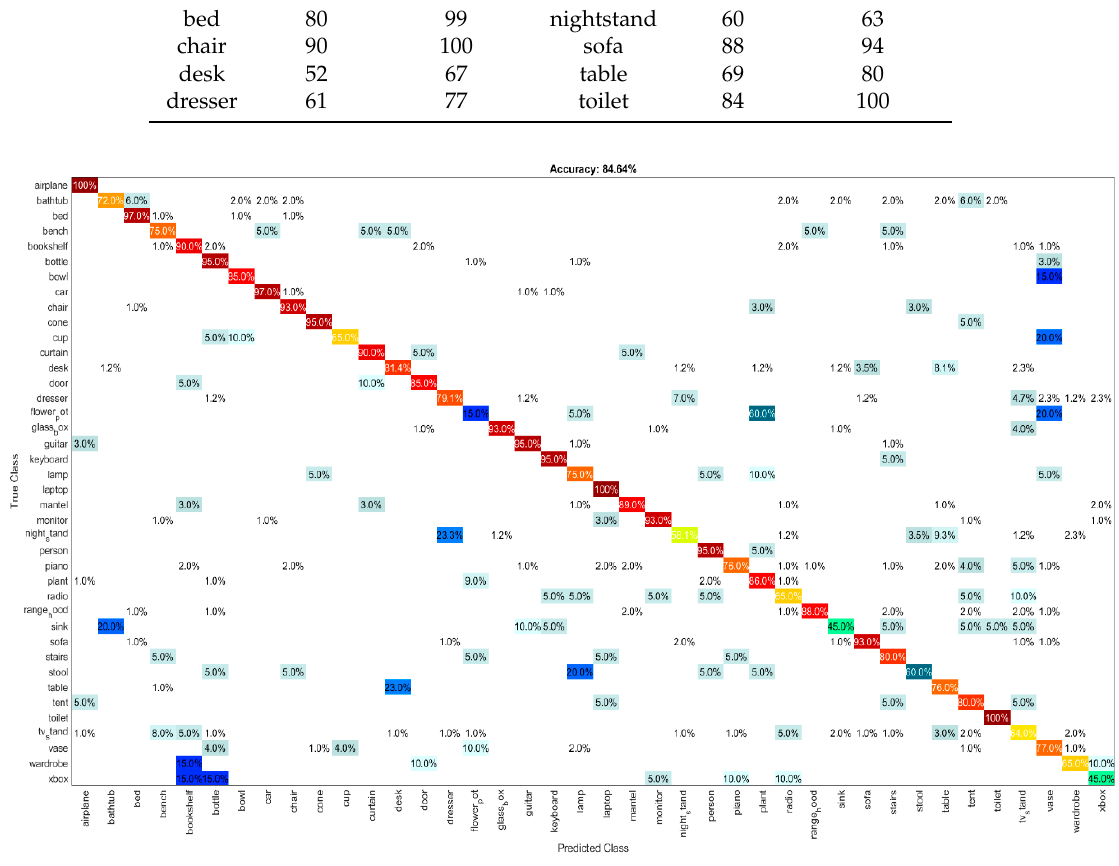
Figure 11. The confusion matrix for dataset: ModelNet40.